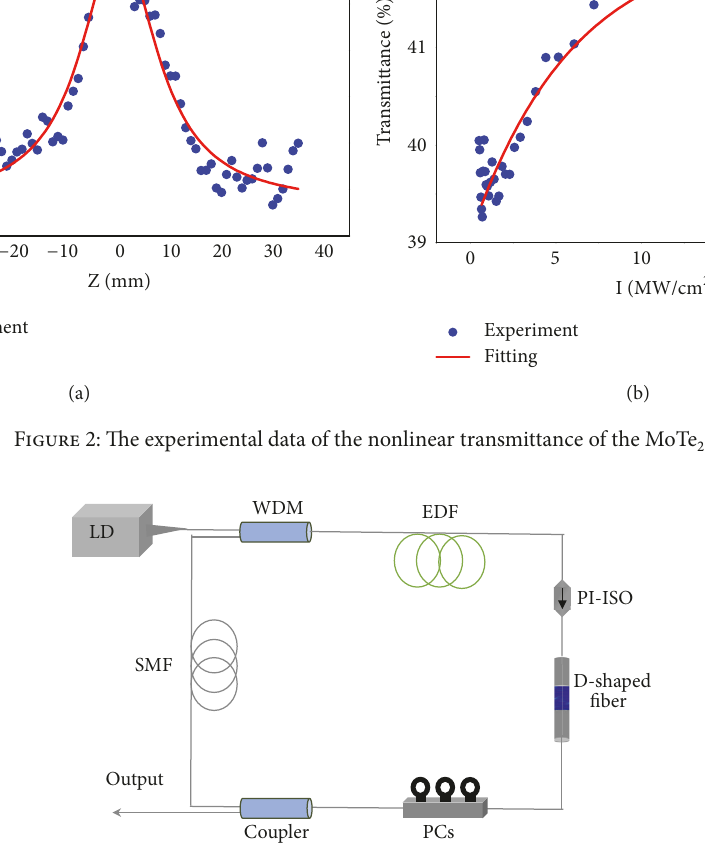
Figure 3: The experimental setup of the Q-switched fiber laser based on MoTe 2